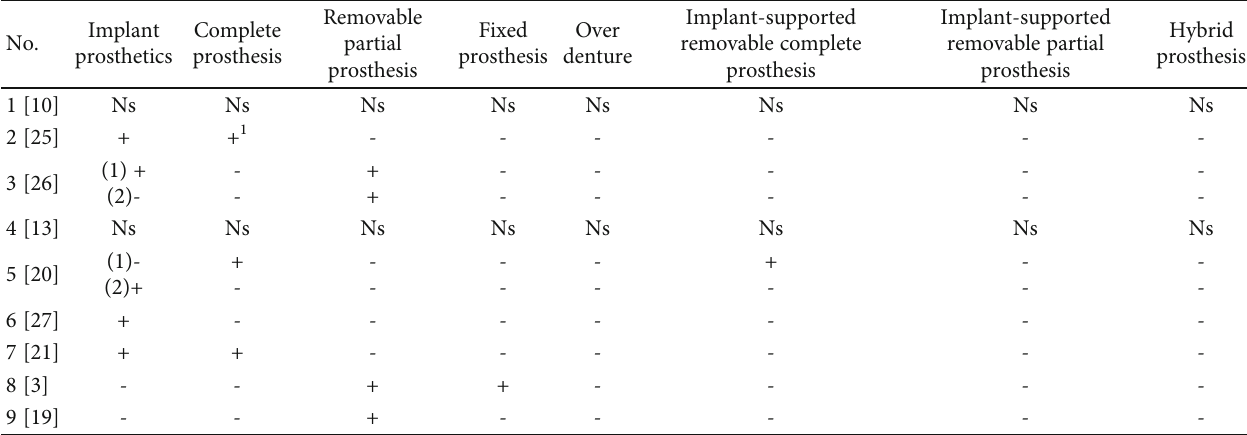
Table 4: Prosthetic